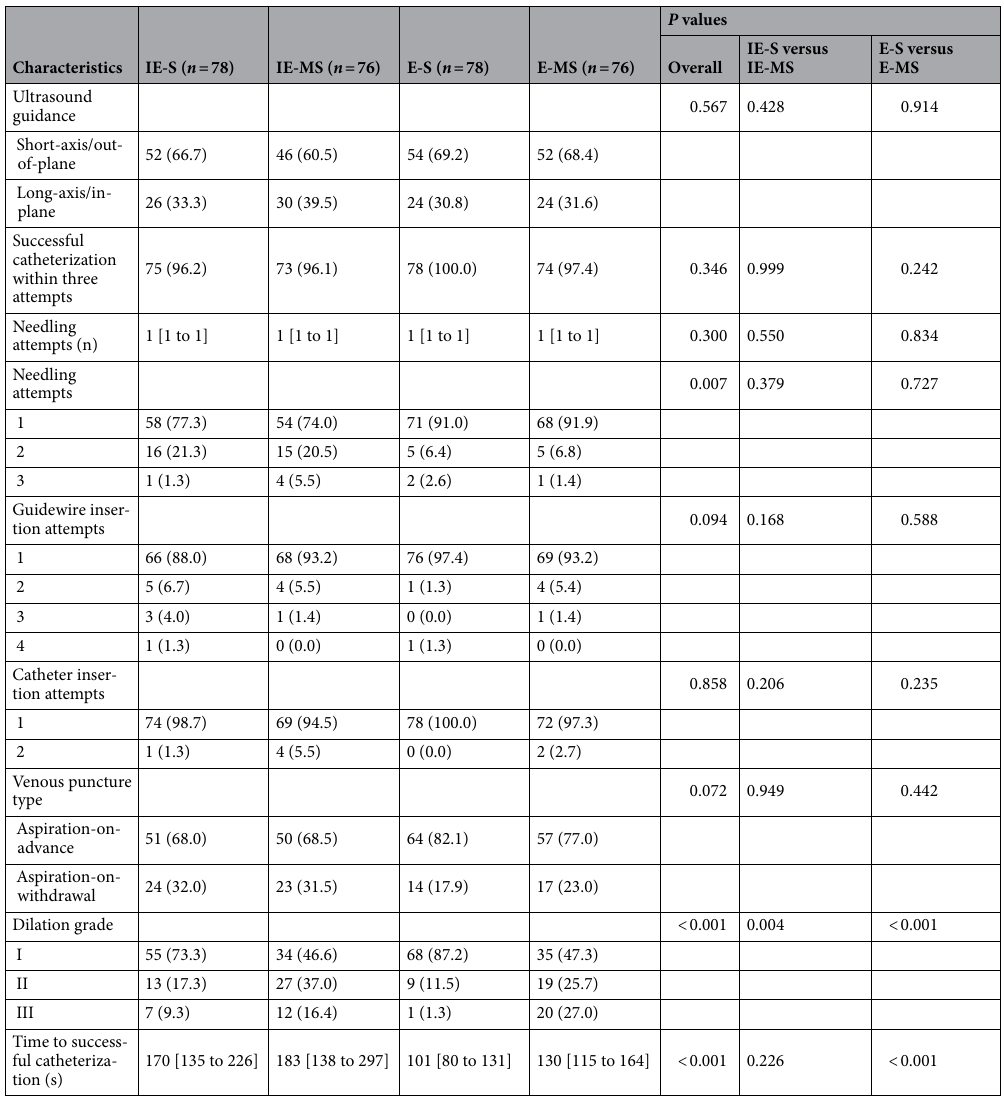
or median [IQR]. For continuous variables, overall P values are the results of Kruskal–Wallis test and other P values are the results of Mann–Whitney U test between the designated two groups. For